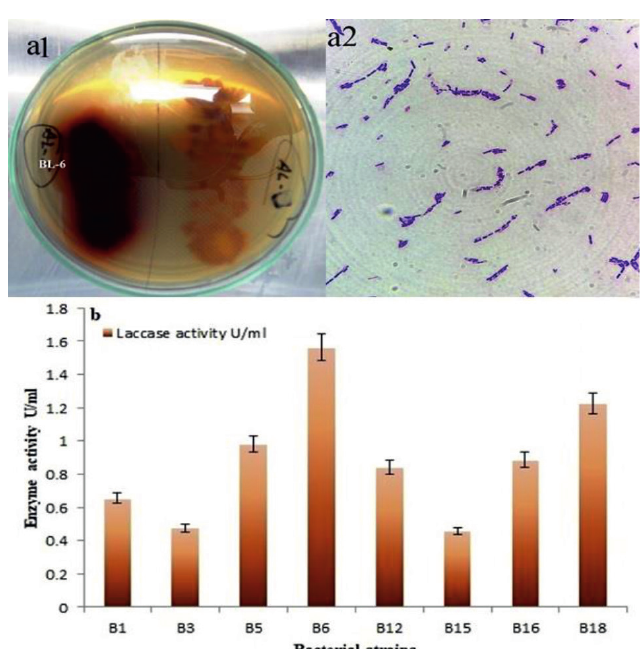
Fig. 1. (a1) Laccase producing bacteria on B and K agar plate (a2) Gram’s staining (b) Screening of laccase producing bacterial